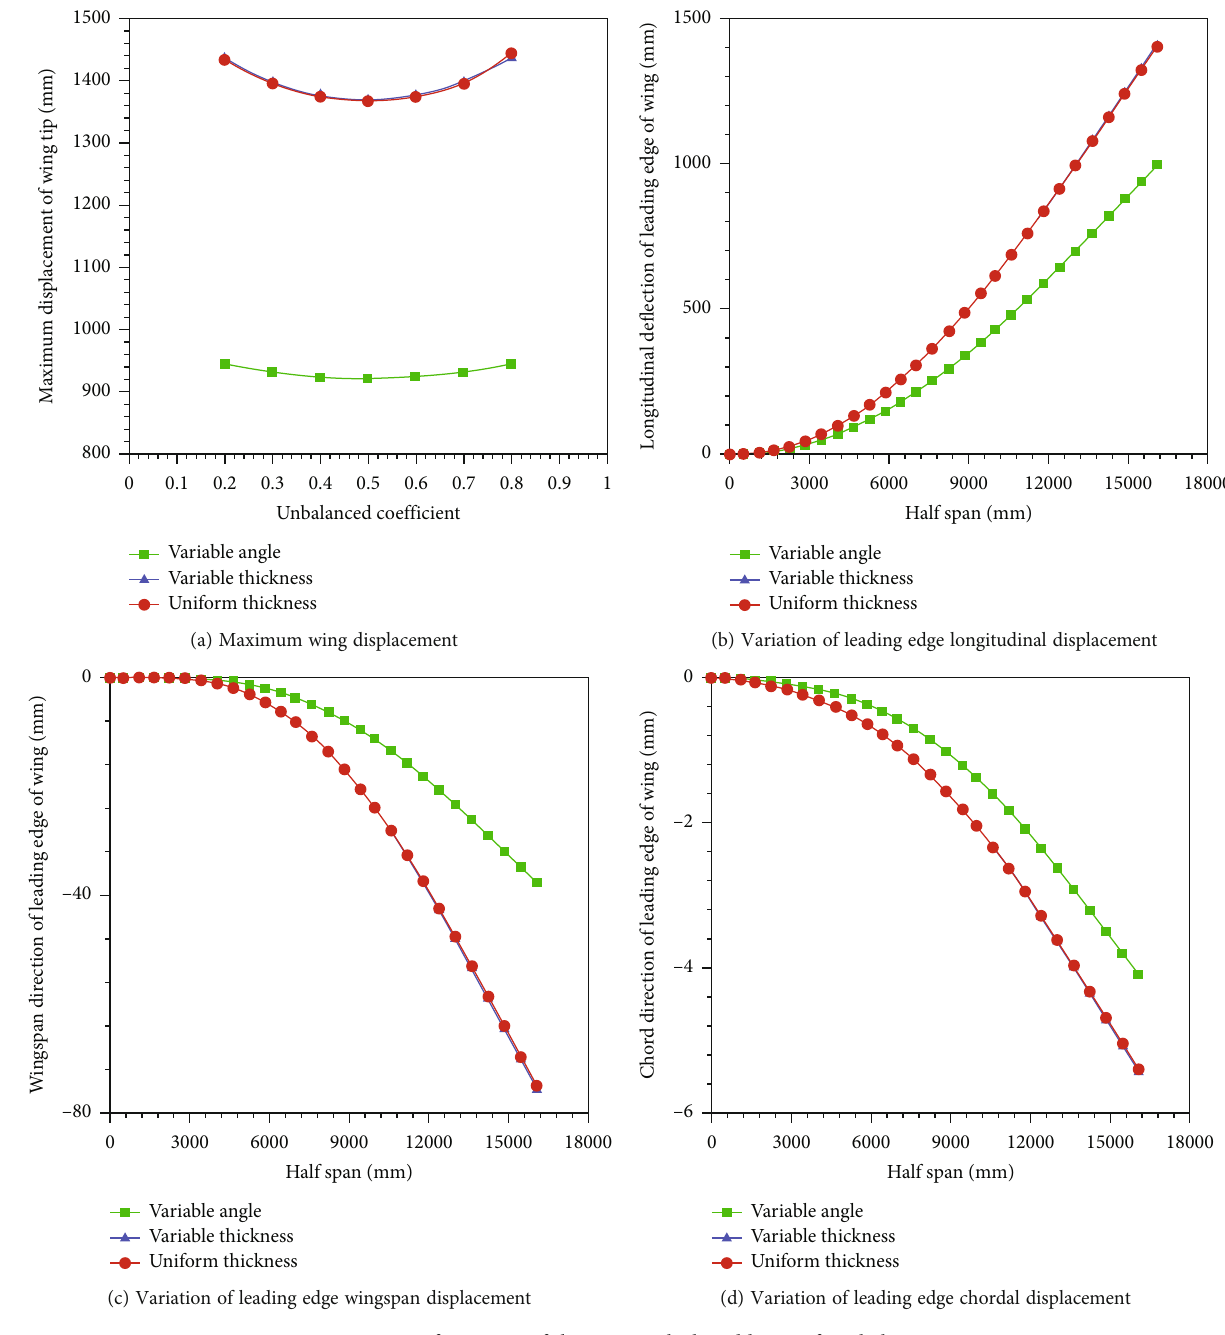
Figure 11: Deformation of the wing with the addition of angle